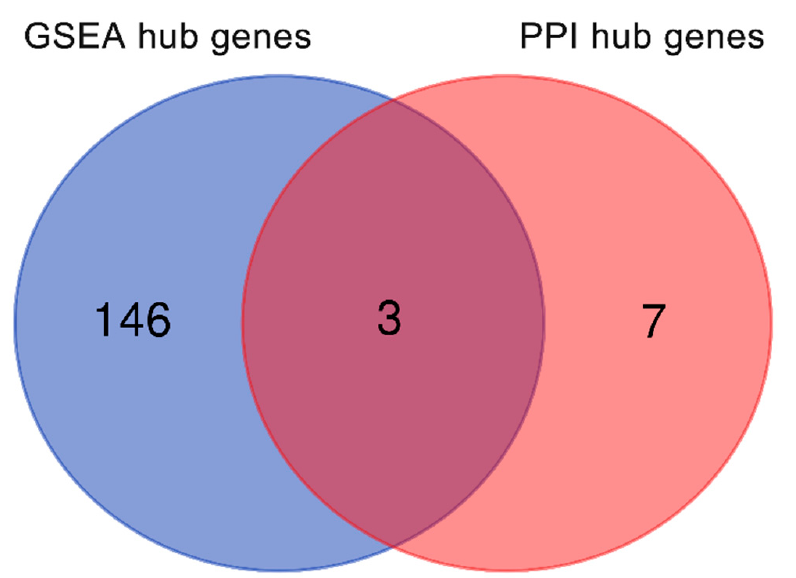
Figure 7. Venn diagram of hub genes. Blue represents GSEA hub genes, while red represents PPI hub genes. There were three genes in common between these two groups.